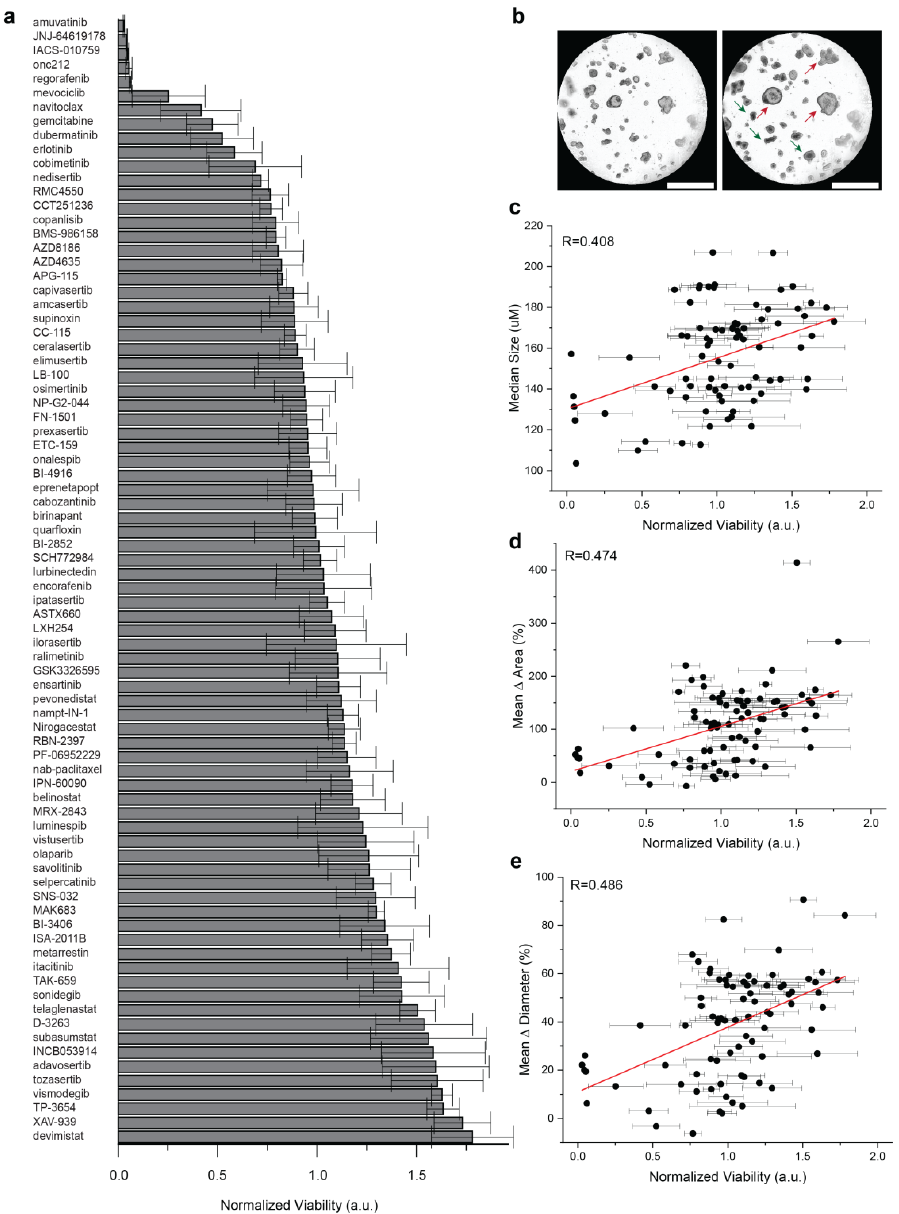
Figure 2. Comparison of population-based organoid response and well-level viability. ( a ) Bar chart of therapeutic response in PDAC2 after 72 h, normalized to control viability across 80 agents used in early phase clinical development. Error bars represent standard deviation for normalized viability across four technical replicates. ( b ) Representative brightfield imaging at 0 h and 72 h, showing evidence of subclonal response heterogeneity after treatment with 1 μM navitoclax, including organoids with phenotypic resistance (red) and response (green). ( c , d ) Dot plots defined to compare normalized well-viability from screening ( a ) against ( c ) median organoid size alone at 72 h; ( d ) mean organoid in area normalized to start of treatment; ( e ) mean organoid in diameter normalized to start of treatment. Error bars represent standard deviations for normalized viability across four technical replicates. The Pearson correlation coefficient (R) is shown with data generated, including the evaluation of n = 6381 organoids.